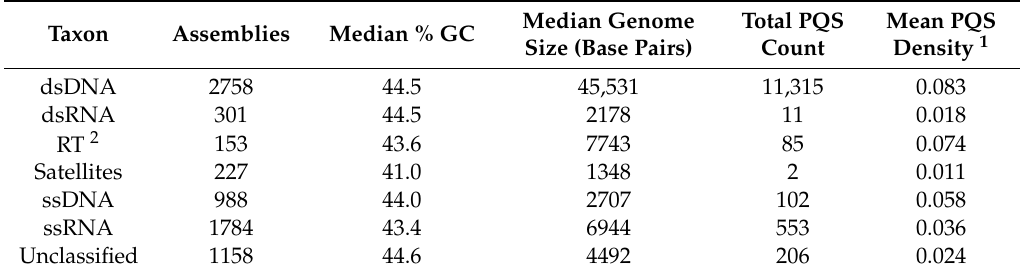
Table 1. Genome metrics and quadruplex sequences in seven viral taxa.